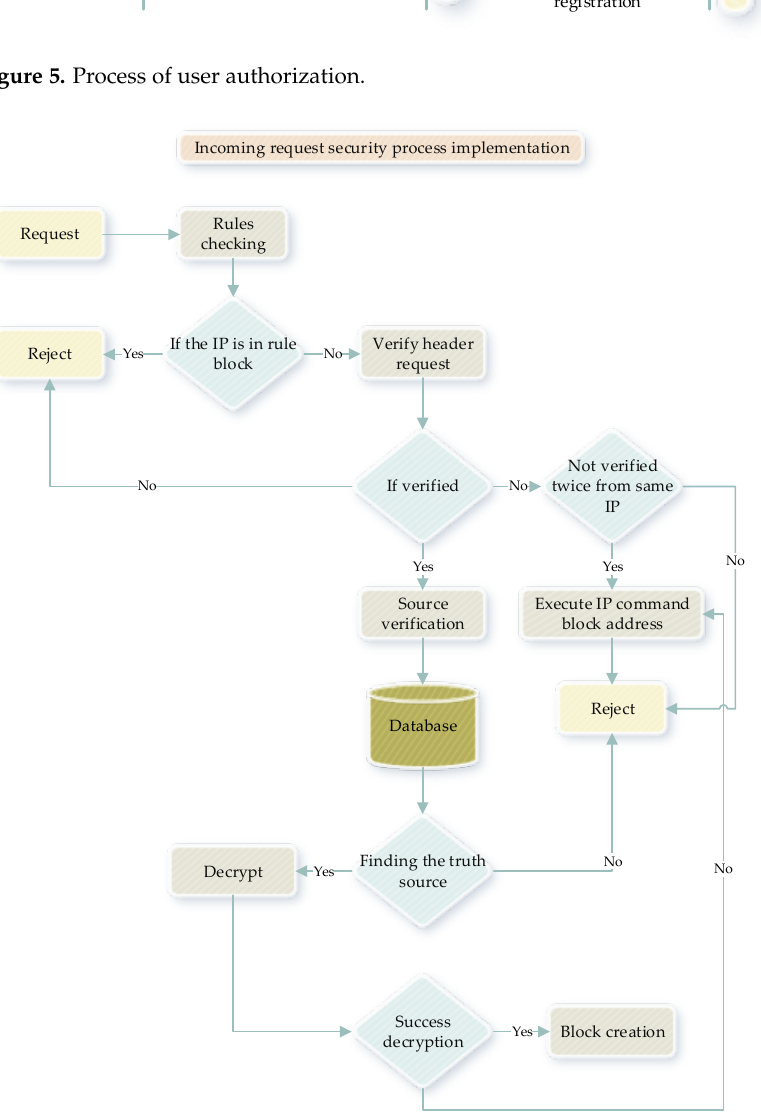
Figure 6. Process of verification